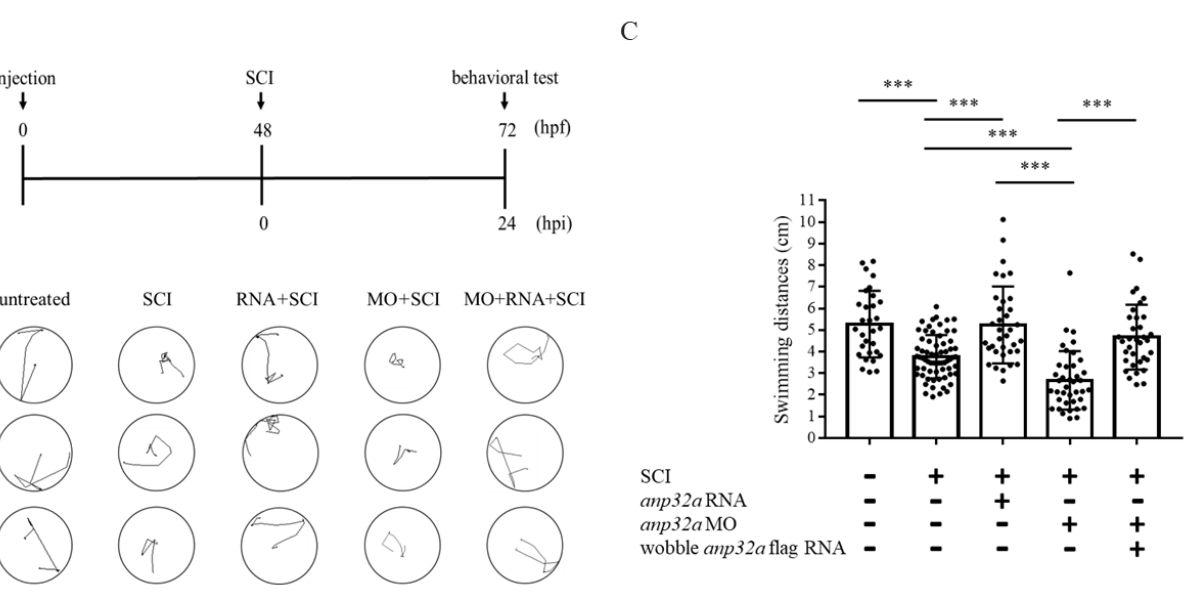
Figure 4. Defective swimming activity was partially recovered in the SCI larvae with Anp32a overexpression. ( A ) Experimental flowchart showing the time course of microinjection of either Anp32a mRNA (RNA) or Anp32a morpholinos (MO), SCI performance and behavior test. Embryos at the one-cell stage were microinjected with either wobble- Anp32a- flag mRNA or Anp32a -MO. Following SCI at 48 hpf, we recorded the swimming trajectory route at 24 hpi. ( B ) To carry out gain-of-function and loss-of function studies, the swimming trajectory route of each fish from three groups was examined, including untreated control (neither injection nor SCI), SCI only (SCI), both wobble- Anp32a- flag mRNA injection and SCI (RNA + SCI), injection of Anp32a -MO and SCI (MO + SCI), and co-injected Anp32a -MO with wobble- Anp32a- flag mRNA injection and SCI (MO + RNA + SCI). ( C ) Quantification and statistical analysis. Swimming distances (cm) were calculated based on the recorded trajectory route shown in ( B ). The data in each group were averaged from all examined larvae (untreated control: n = 30; SCI: n = 66; RNA + SCI: n = 35; MO + SCI: n = 39; MO + RNA + SCI: n = 35). One-way ANOVA, followed by Tukey ’ s multiple comparison test, was used to perform statistical analysis (***, p < 0.001; error bars indicate mean ± SD).